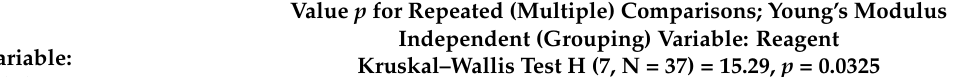
Table 7. Results of repeated (multiple)